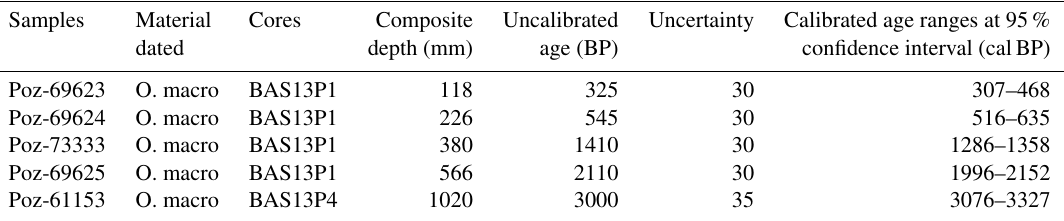
Table 1. List and depth reported in the composite depth of 14 C dates for the Lake Bastani cores. The composite depth is obtained from Fig. S2. Samples Material Cores